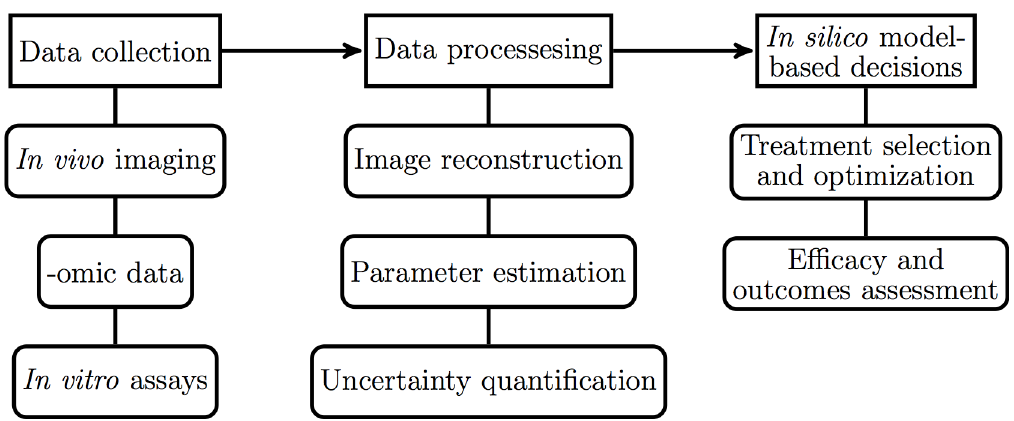
Fig 1. Information flow in precision medicine. The information pipeline for precision medicine involves collecting patient- specific data, using this data to personalize validated mathematical and computational models, then using the output of such models to perform treatment selection, optimization, and assess